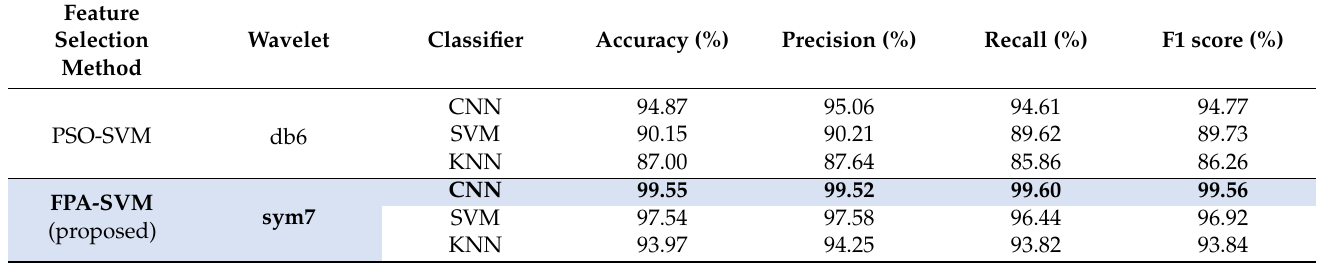
Table 8. Comparison of the performance of various classifiers created with the selected features by the proposed FPA-SVM and PSO-SVM wrapper approaches for wavelet families providing the best classification performance.